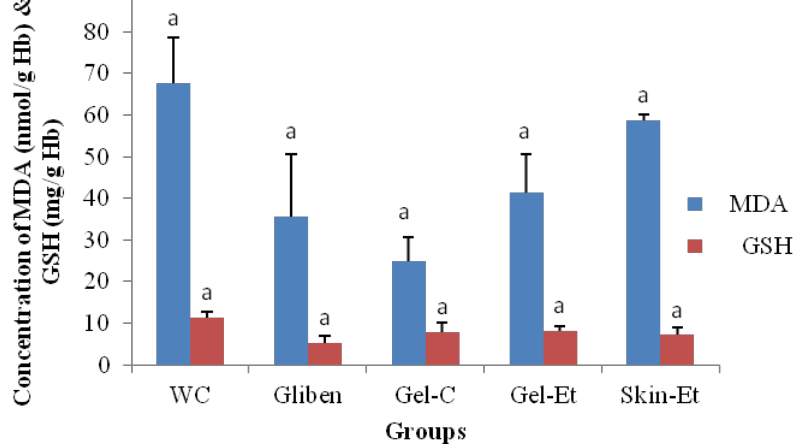
Figure 4. Effects of different treatments on the erythrocyte MDA and GSH levels in type 2 diabetic model